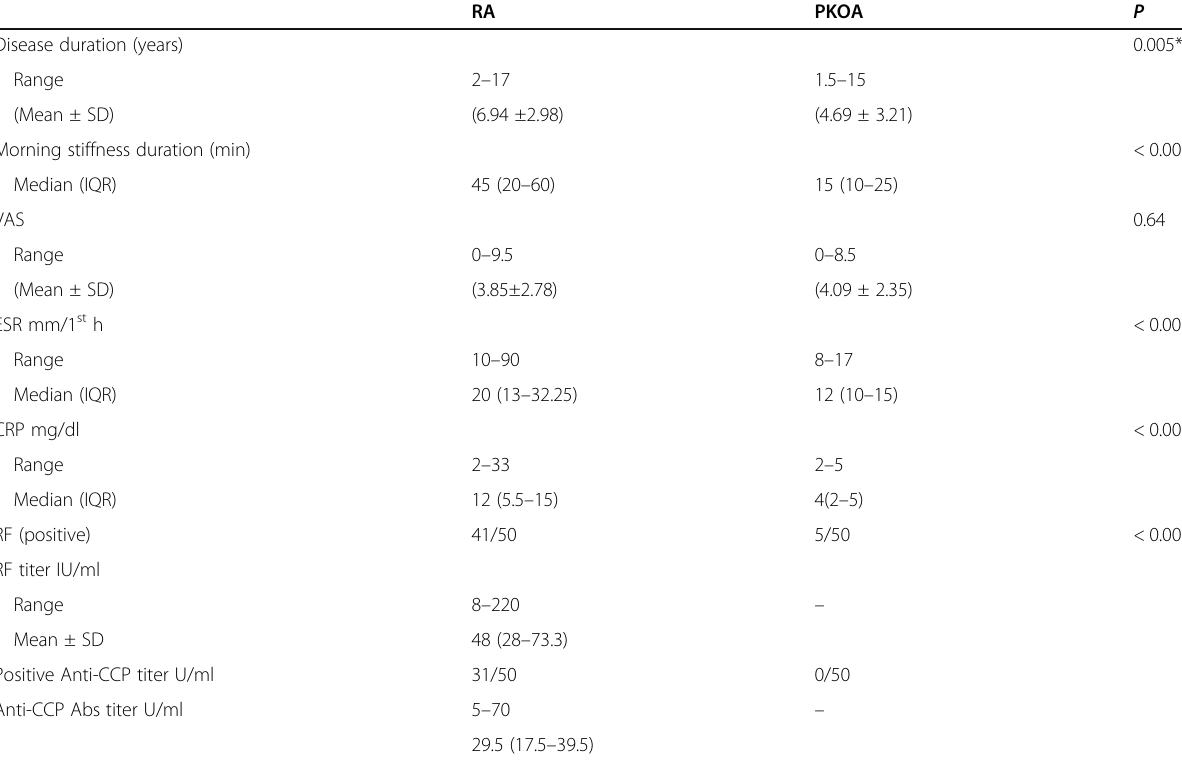
Table 2 Clinical and laboratory characteristics of the rheumatoid arthritis and primary knee osteoarthritis patients RA PKOA P Disease duration (years)